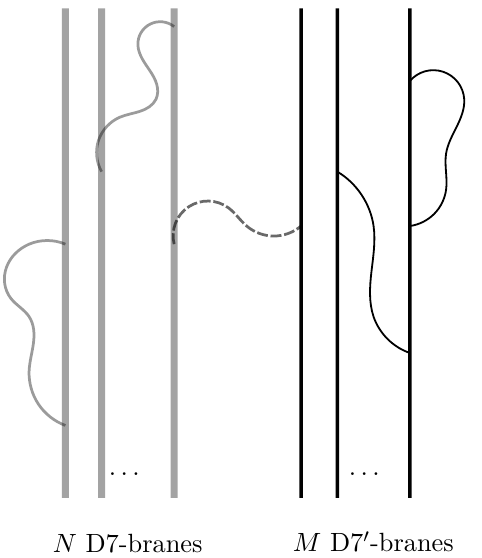
Figure 1 . A background flux is turned on on the N D7 branes. The D7 / D7 and D7 0 /D7 0 open strings are untwisted, the mixed ones (depicted as dashed) are instead twisted. and end on branes of different type. The 7/7 and 7 0 /7 0 strings are untwisted and contain exactly the same physical states of the original strings. In particular they give rise to the same effective action (2.1) for the group U( N ) (in presence of the background (2.12)) and for the group U( M ), respectively. The 7/7 0 or 7 0 /7 strings, instead, are twisted and their spectrum is completely different, depending on the values of the